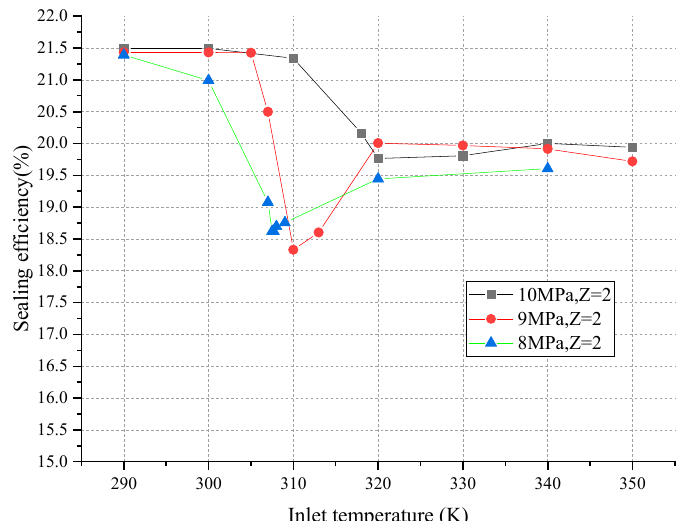
Figure 23. The e ff ect of inlet condition on sealing e ffi ciency. Figure 23. The effect of inlet condition on sealing efficiency. Figure 23. The effect of inlet condition on sealing efficiency.